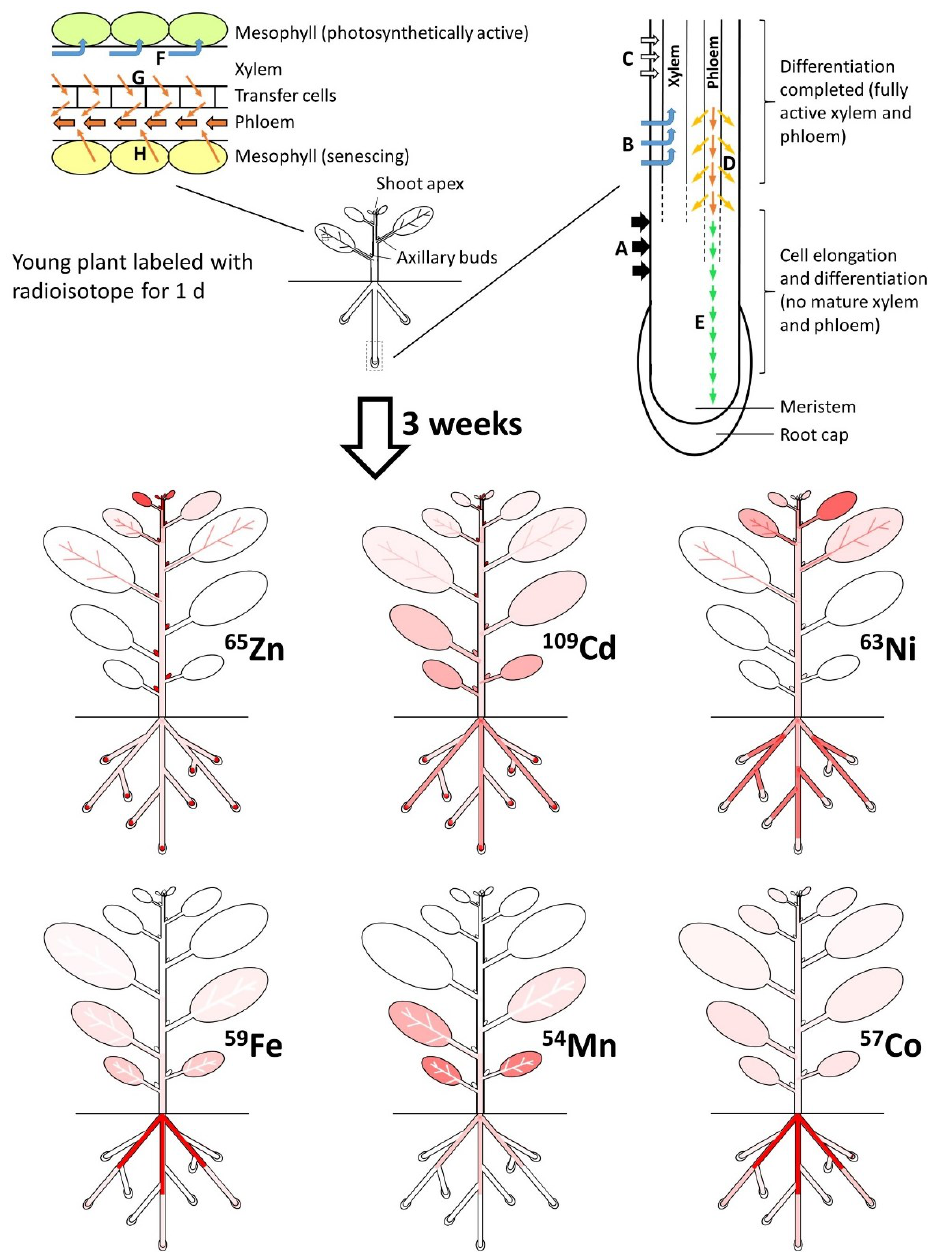
Figure 4. Scheme summarizing the processes involved in the distribution and redistribution of heavy metals in plants. The relative distribution patterns (red color) of 65 Zn, 109 Cd, 63 Ni, 59 Fe, 54 Mn and 57 Co are based on autoradiographs with various plant species emphasizing important findings. The following processes are involved in generating these radionuclide-specific distribution patterns: insolubilization at the roots surface and in the root apoplast ( A ); uptake and loading into the root xylem ( B ); uptake and retention in root cells ( C ); basipetal transport to the roots via the phloem ( D ); cell-to-cell transport in meristems and regions without functional phloem ( E ); transport with the transpiration stream in the xylem to mesophyll cells ( F ); transfer from xylem to phloem via transfer cells in small bundles ( G ); and remobilization from senescing leaves and transport to sinks via the phloem ( H